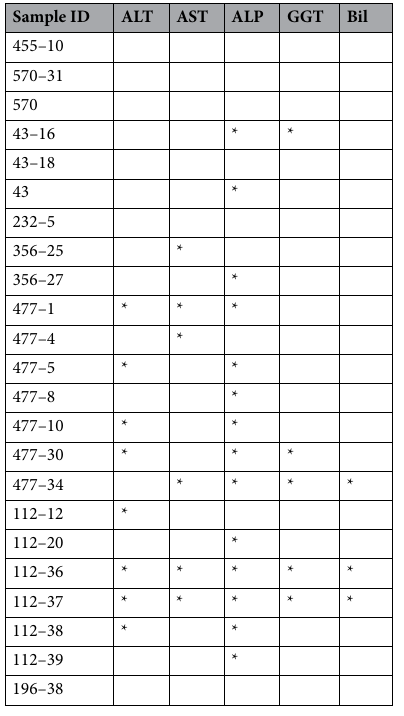
Table 1. Biochemical profile of the DDH positive canine sera. Asterisk indicates values exceeding the normal upper limits for alanine aminotransferase (64 UI/L), aspartate aminotransferase (54 UI/L), alkaline phosphatase (7 UI/L), gammaglutamyl transpeptidase (7.0 UI/L) and total bilirubin (0.30 mg/dL). ALT alanine transaminase; AST aspartate transaminase; ALP alkaline phosphatase; GGT gamma glutamyl trasnpeptidase; Bil